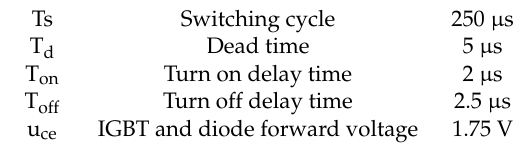
Figure 12. The amplitude of the transfer function of voltage error and observed speed. Table 2. The parameters of the nonlinear effects of the experimental platform.